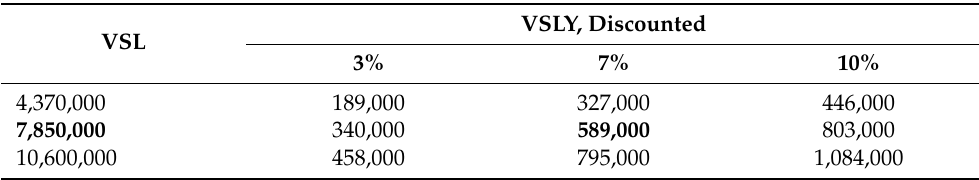
Table 2. Values for VSL and VSLY used in this study. Values for central estimates are in bold. Values are AUD